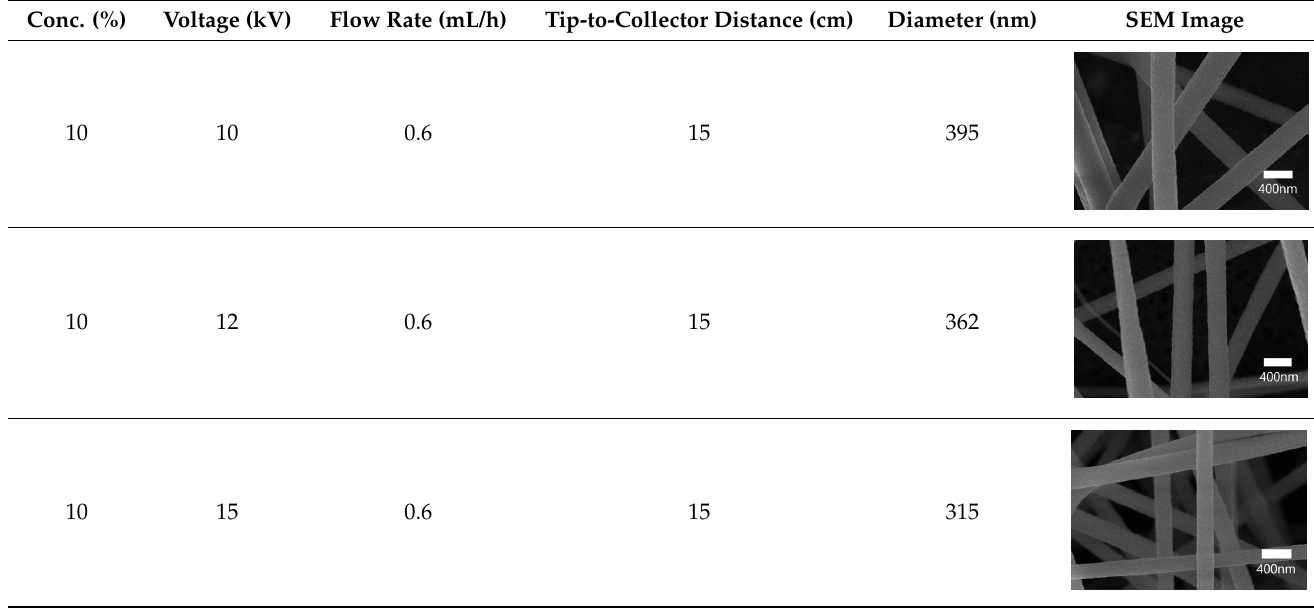
Table 1. Optimization of electrospinning parameters for PAN-electrospun membrane.